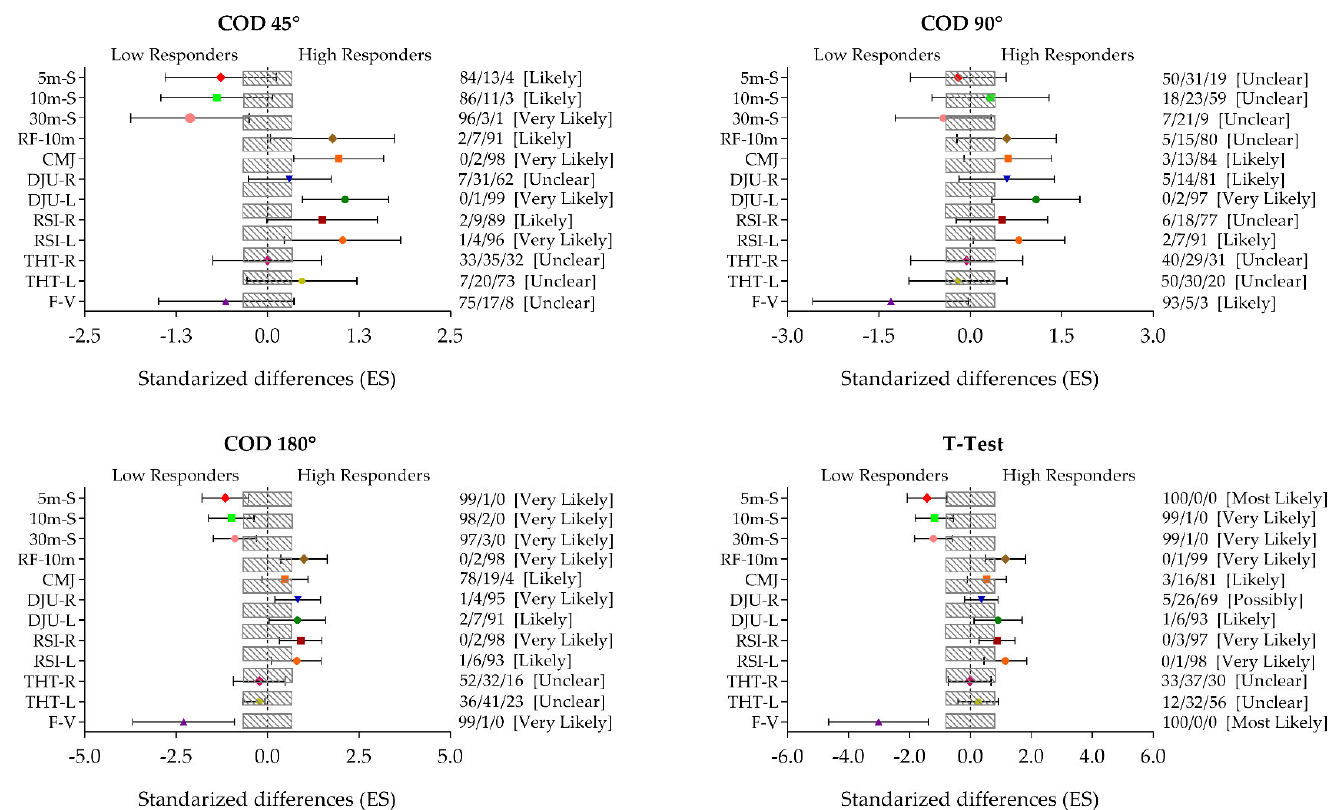
Figure 1. Between-group comparisons for the 5-, 10-, and 30-m linear sprint, the rate of force at 10 m, the vertical jump through countermovement jump and drop jump unilateral, the reactive strength index, the horizontal jump through triple hop test, and the vertical force–velocity profile between low responders (LH) and high responders (HR) classified by each change of direction (COD) execution time. The model was adjusted by age. Bars indicate uncertainty in the true mean changes with 90% confidence intervals. Trivial (shaded) areas were calculated from the smallest worthwhile change. Quantitative chances of better or worse effects were determined as follows: < 1%, almost certainly not; 1–5%, very unlikely; 5–25%, unlikely; 25–75%, possible; 75–95%, likely; 95–99%, very likely; and > 99%, most likely [33,34]. R: Right; L: Left; RF: Rate of force; CMJ: Countermovement jump; DJU: Drop jump unilateral; RSI: Reactive strength index; THT: Triple hop test; F–V: Vertical force–velocity profile; COD: Change of direction; ES: Effect size.